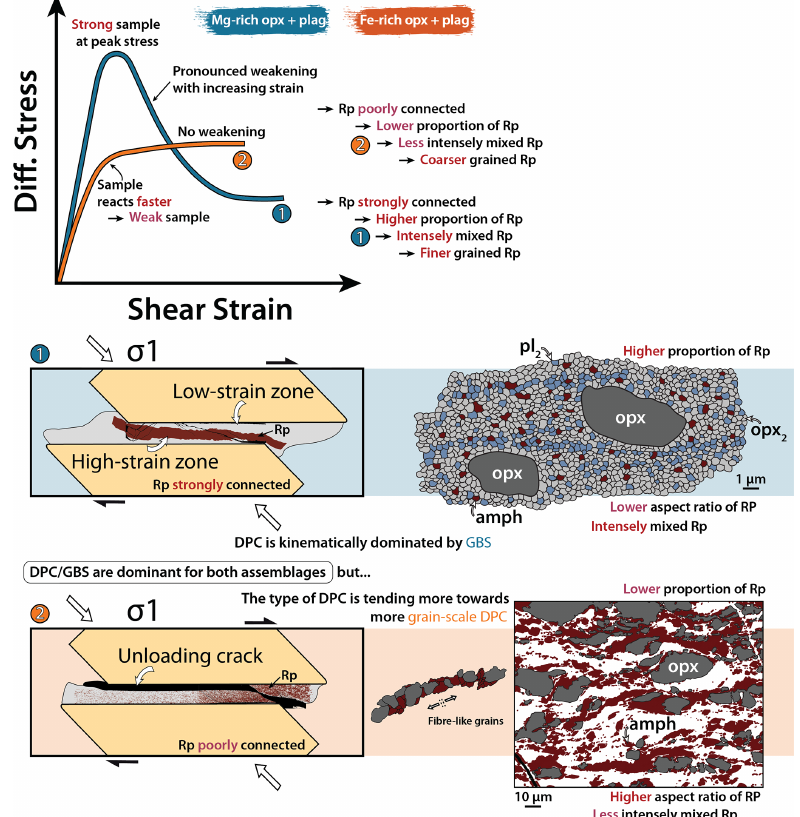
Figure 14. Schematic mechanical and microstructural evolution of the deformed Mg-rich opx + plag and Fe-rich opx + plag assemblages. Rp: reaction product, opx: orthopyroxene, pl: plagioclase, amph: